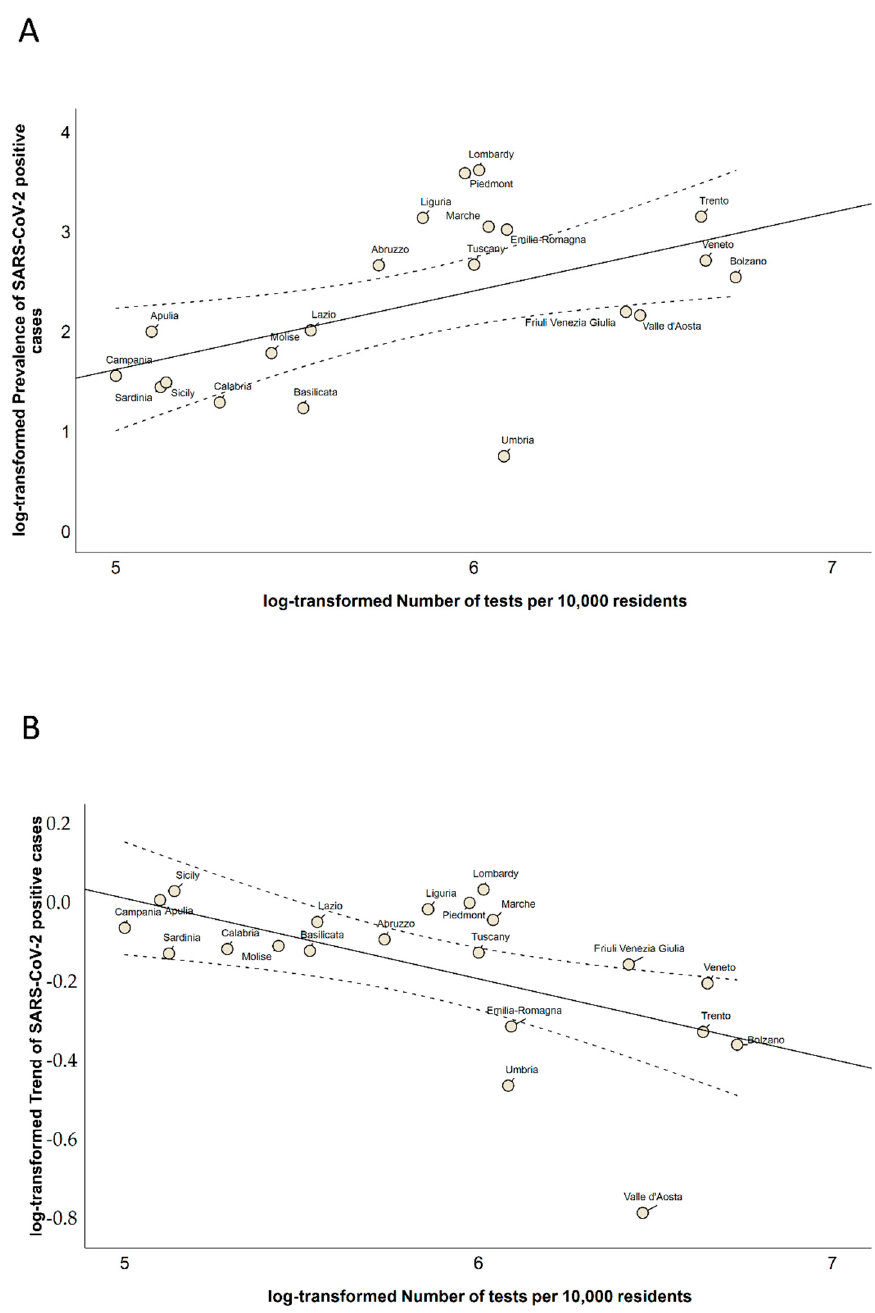
Figure 2. Scatter plots of the relationships of the number of tests performed with ( A ) the prevalence of SARS- CoV-2 positive cases and ( B ) their trend. Indicators are reported as log-transformed